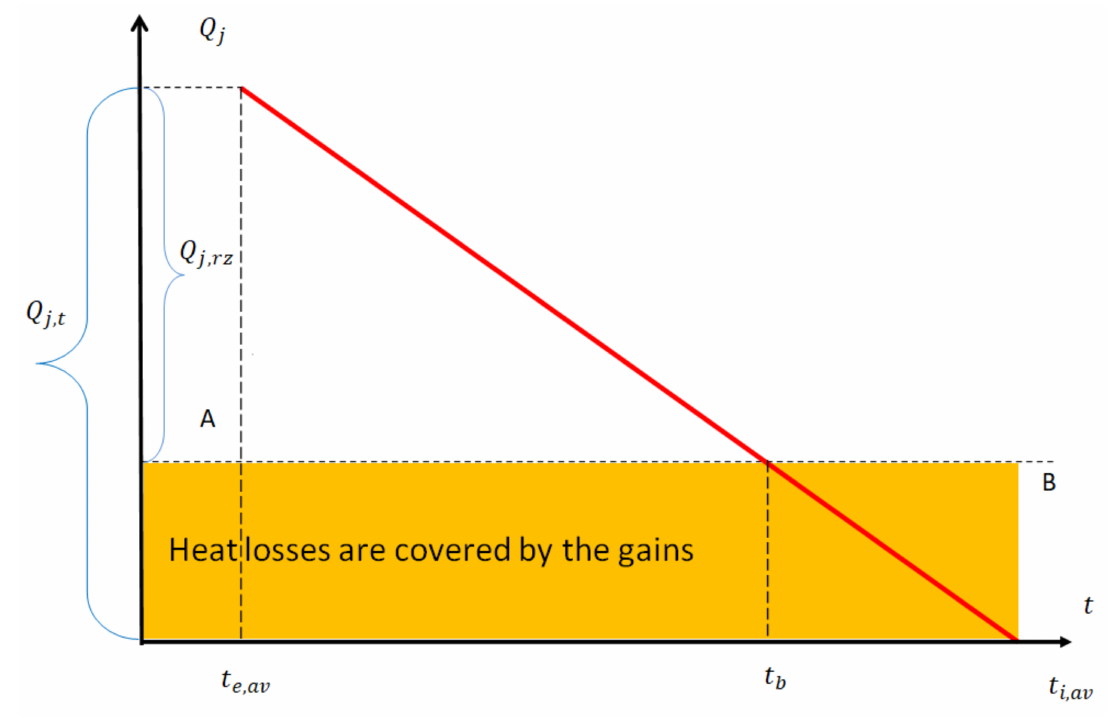
Figure 2. The method of determining the actual base temperature of a building ( t b ), depending on its thermal parameters, users’ behaviour, and meteorological conditions of the heating